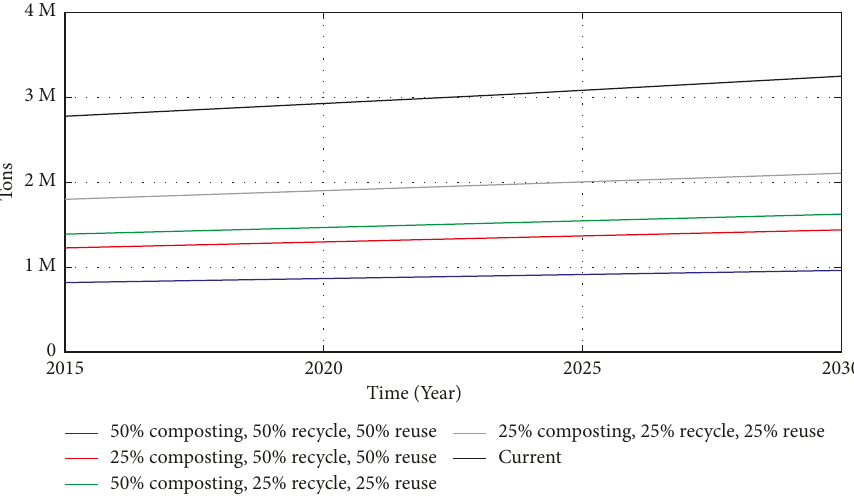
Figure 5: Simulation results with various scenarios of composting, recycling, and